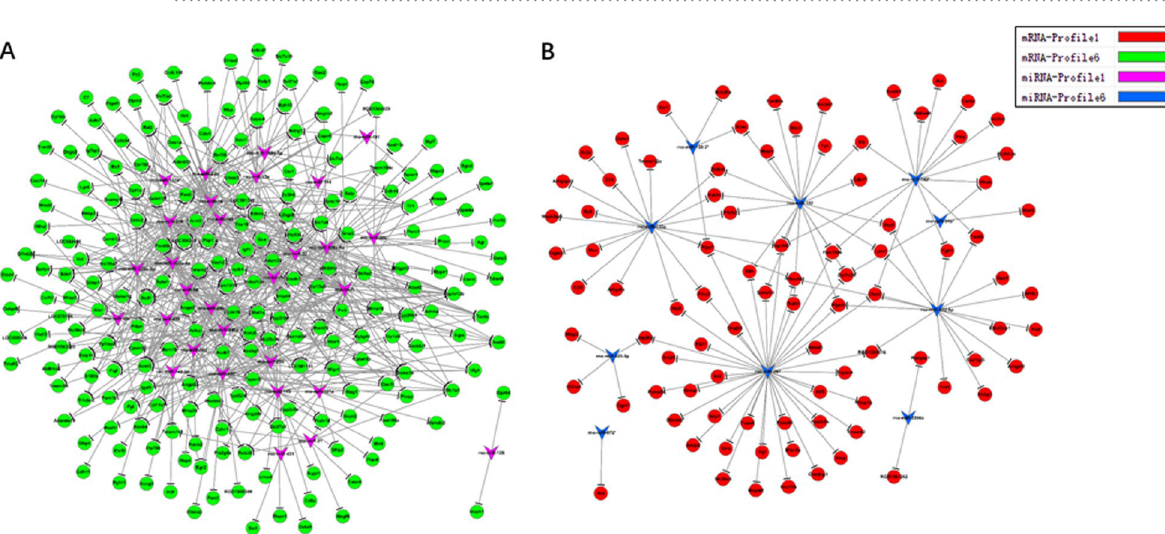
Figure 8. The miRNA-Gene-Network for miRNAs in the Profile NO. 1 ( A )/Profile NO. 6 ( B ) and their target mRNA, the circle represents mRNA and the shape of arrow represents miRNA, and their relationship was represented by grey